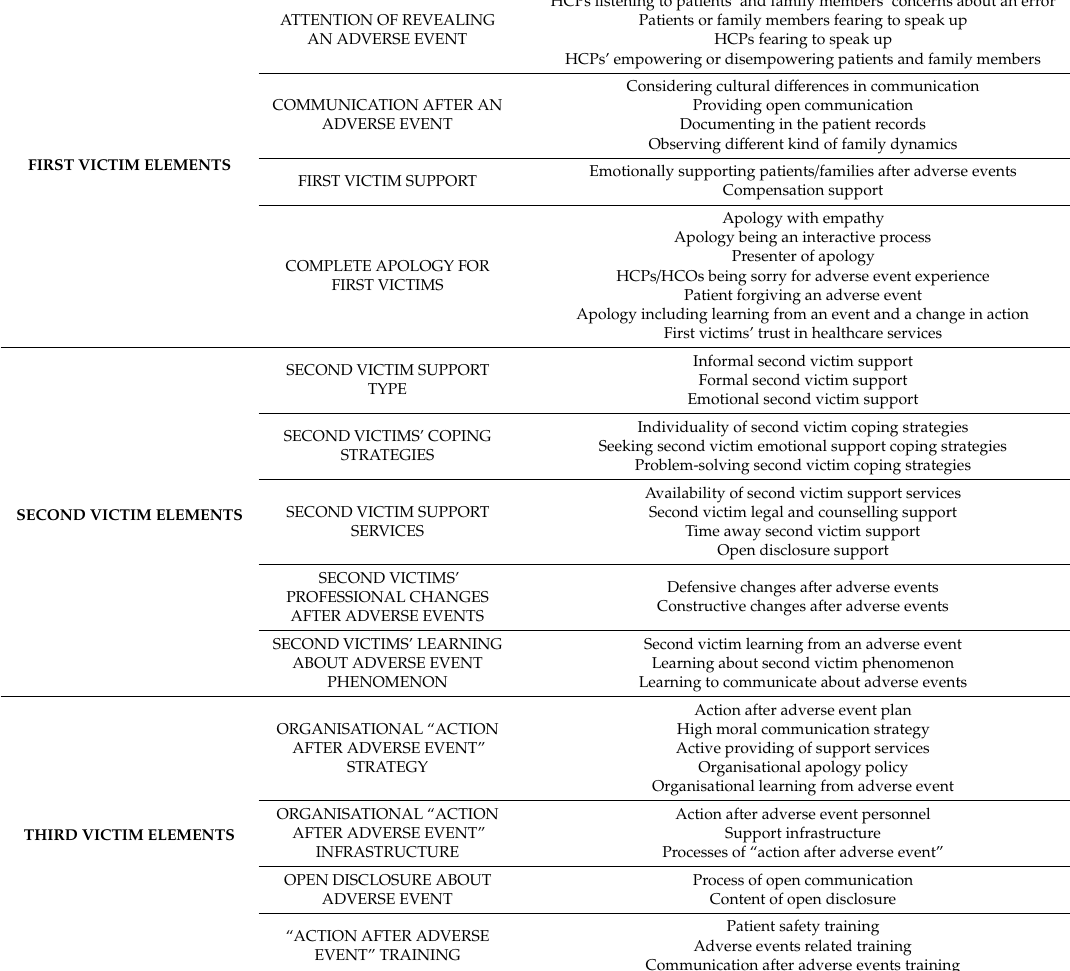
Table 2. “Action after adverse events” regarding first, second and third victim